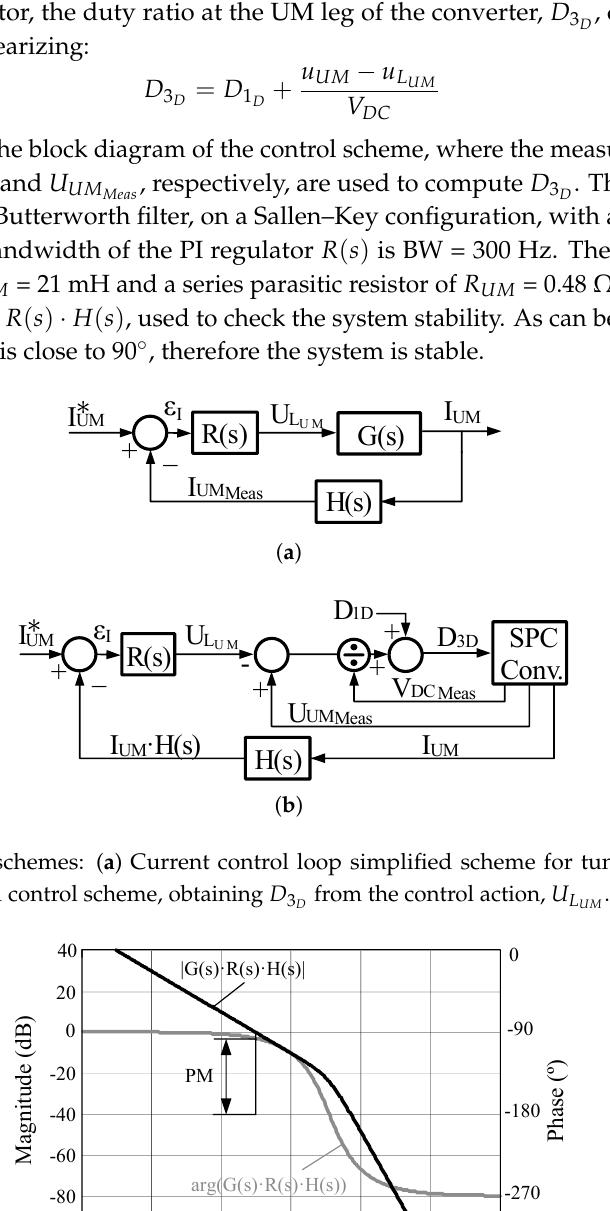
Figure 14. Bode plot with the Phase Margin (PM) of the